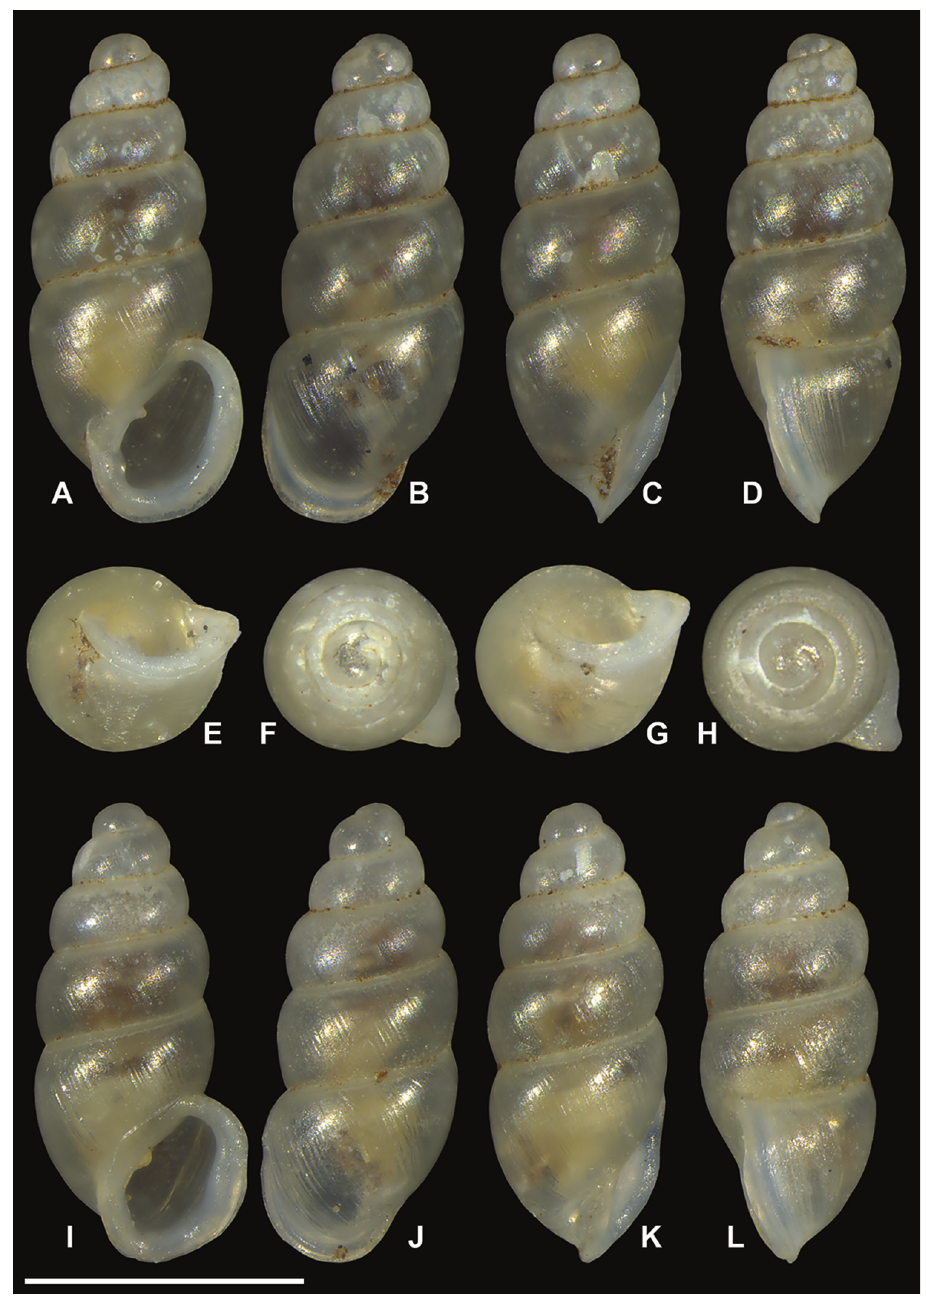
Figure 4. Carychium hardiei sp. n. A – F holotype (NMBE 549920/1) G–L paratype shell (NMBE 549921/8). Scale bar 1